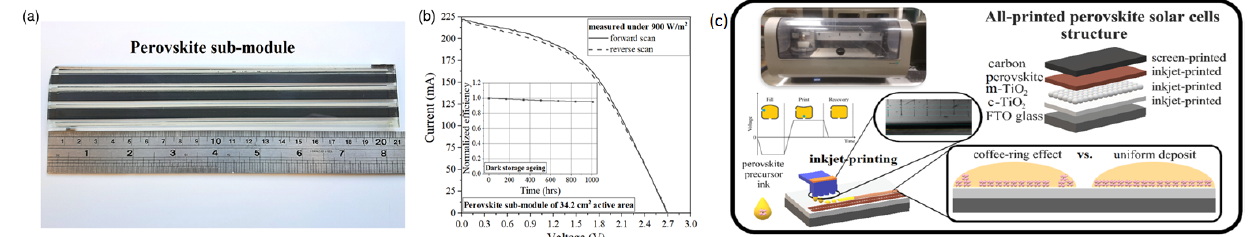
Figure 19. ( a ) Image of the fully printed perovskite submodule of 34.2 cm 2 active area. ( b ) Repre- sentative I–V curve (forward and reverse scan) of the perovskite submodule measured under 900 Wm − 2 incident solar irradiance. ( c ) Schematic illustration of inkjet printing processing of perovskite precursor inks and structure of fully printed PSCs [97]. (Reproduced from Ref. [97], 10.1002/solr.202200196, with permission.)